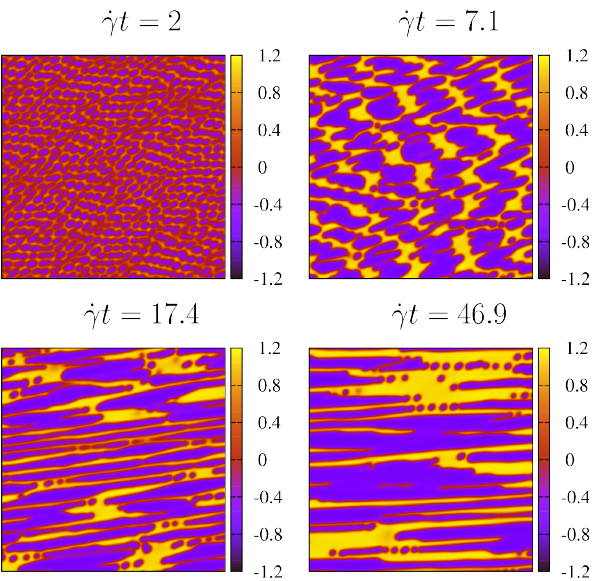
Figure 4. Configurations of the system at consecutive times in the strong shear regime ( ˙ γ t D = 4.0) with λ = 3. A central portion of size 512 × 512 of the whole lattice is